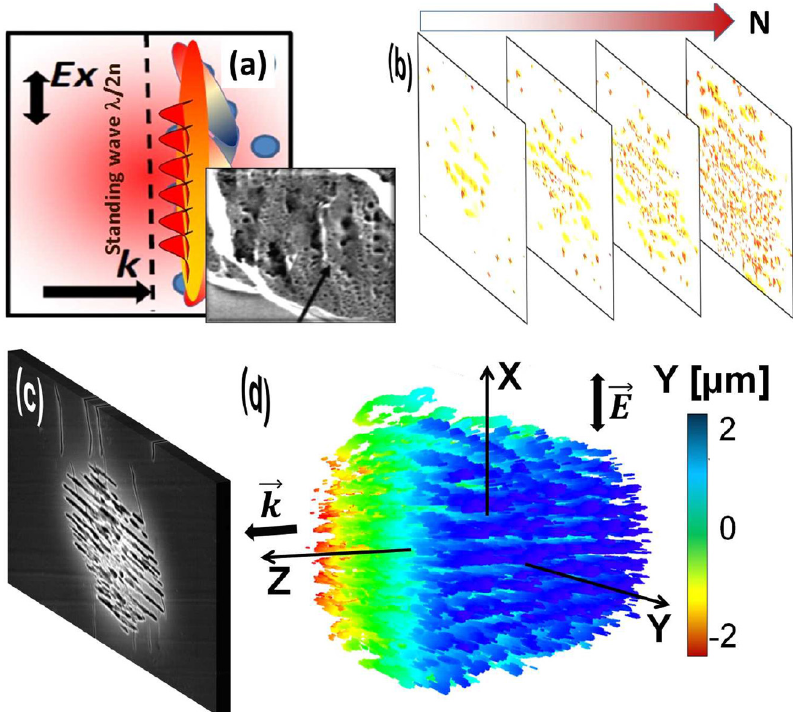
Figure 9: (a) The conceptual scattering model. Inset: molecular decomposition centers in glass. Reprinted with